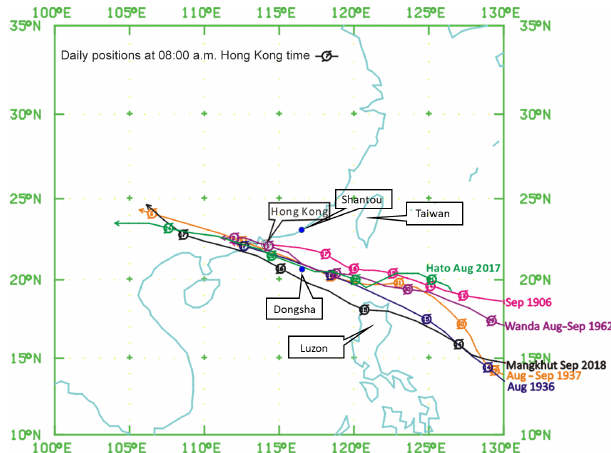
Figure 1. Daily positions at 08:00 Hong Kong time of the ty- phoons affecting Hong Kong on 13–18 September 1906 (Typhoon Sep 1906), 14–17 August 1936 (Typhoon Aug 1936), 29 August to 3 September 1937 (Typhoon Aug–Sep 1937), super typhoon Wanda from 29 August to 2 September 1962 (Wanda Aug–Sep 1962), su- per typhoon Hato on 21–24 August 2017 (Hato Aug 2017), and su- per typhoon Mangkhut on 14–17 September 2018 (Mangkhut Sep